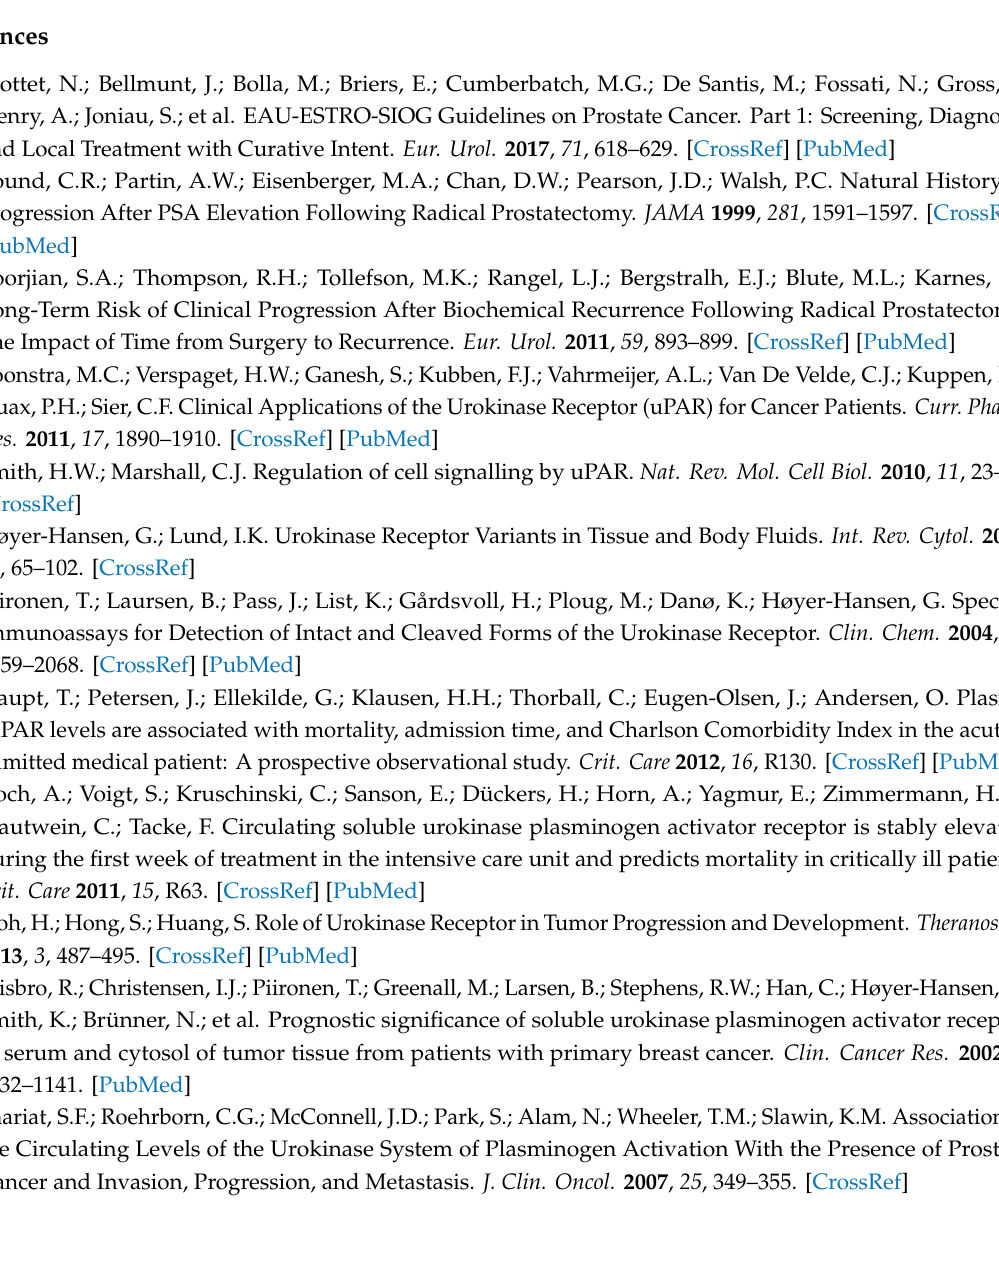
stratified for quartiles uPAR I, Figure S3: Spline curves of hazards of biochemical recurrence after external beam radiation therapy for plasma uPAR levels at baseline, Table S1: Univariate analysis for all adjusted variables in multivariate analysis, Table S2: Patient characteristics for men with second plasma uPAR measurement, Table S3: Univariate analysis of change in plasma uPAR after radical prostatectomy and biochemical recurrence, Table S4: Subgroup analysis of plasma uPAR levels based on D’Amico categorization, Table S5: Median and tertile analysis of plasma uPAR, Table S6: subsequent treatment for men with biochemical recurrence (N = 125), Table S7: Univariate analysis of biochemical recurrence after external beam radiation therapy (N = 159) stratified for plasma uPAR quartiles, Text S1: Detailed number of excluded men based on exclusion